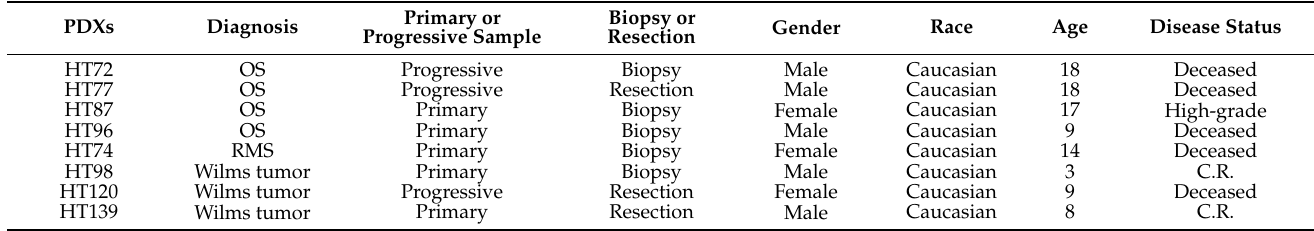
Table 1. Overview of patient characteristics for the PDX